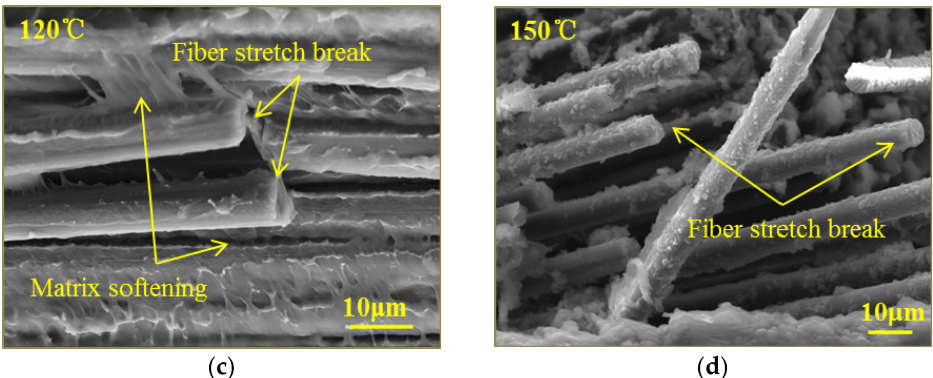
Figure 11. SEM micrographs of CF/PPS specimen under the strain rate of 1450/s at different temperatures: ( a ) 23 °C; ( b ) 90 °C; ( c ) 120 °C; ( d ) 150 °C.